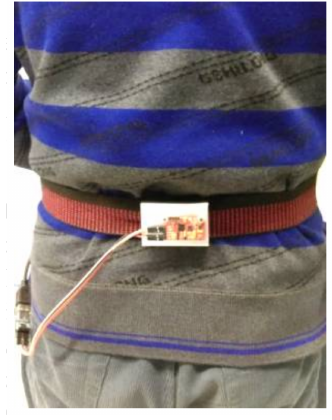
Figure 6. The wearing